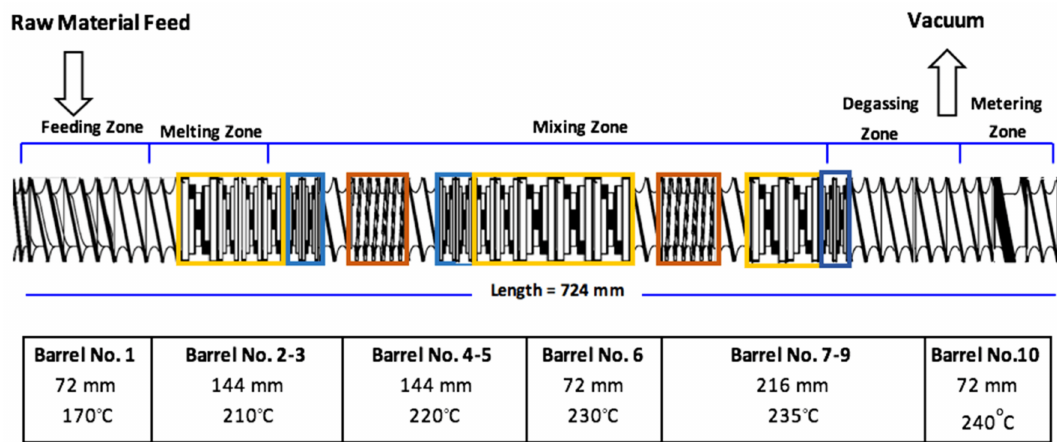
Figure 2. Modular extrusion screw configuration based upon individual barrel sections and screw elements. The color boxes show the position of the dispersive and distributive kneading elements along the screw shaft (length of 724